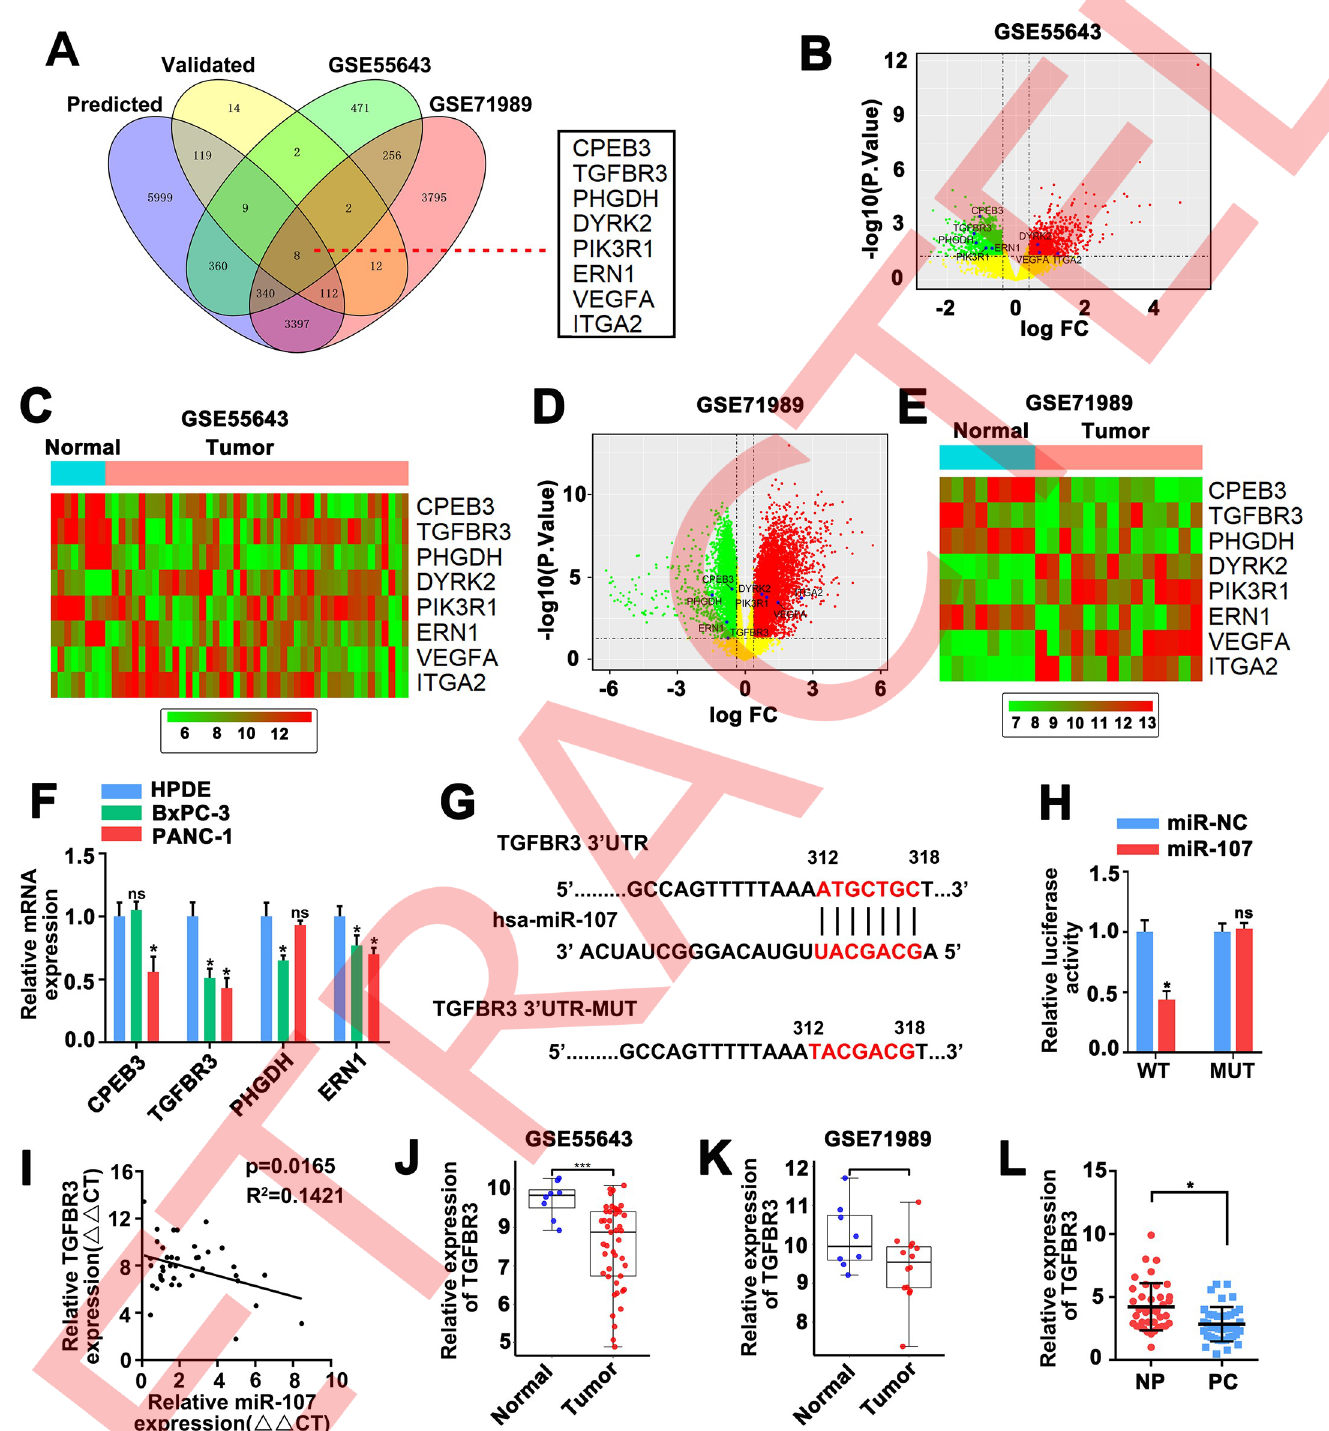
Fig 4. MiR-107 directly targets TGFBR3. A, Overlapping analysis of DEGs from GSE55643 and GSE71989 with predicted and validated target genes according to miRWalk database uncovered 8 consensus target genes. B, C, Volcano plot of 8 DEGs unearthed from GSE55643, and GSE71989, respectively. D, E, Heatmap of 8 DEGs uncovered from GSE55643, and GSE71989, respectively. F, QRT-PCR analysis of mRNA level for CPEB3, TGFBR3, PHGDH and ERN1 in BxPC-3 and PANC-1 cells. G, miR-107 binding site on 3’UTR of TGFBR3 predicted by TargetScan and miRDB. H, cells transfected with a wild-type (WT) TGFBR3 3’UTR vectors showed a relatively weaker luciferase activity (p < 0.05), however, when transfected with a mutated type (MUT) TGFBR3 3’UTR, no significant differences were observed. I & J, Histograms showed obvious higher expression of TGFBR3 in PC tumor samples than that in normal samples from GSE55643 and GSE71989